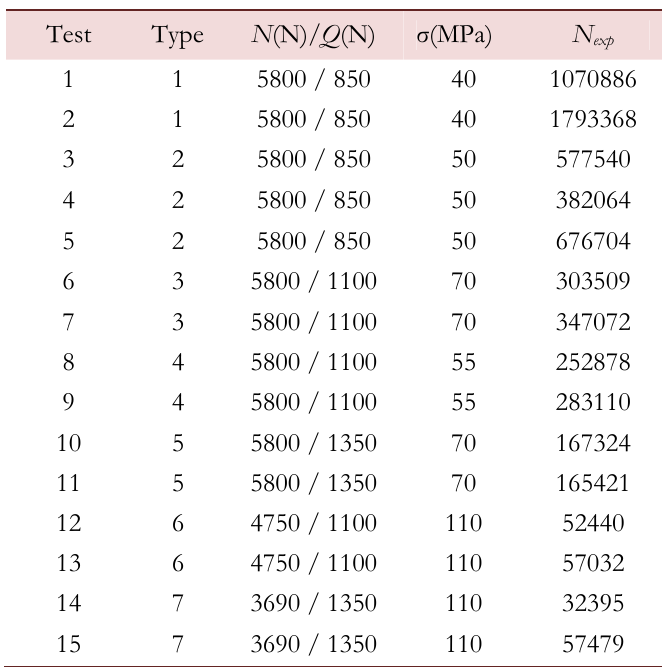
Table 1: Loads ( N and Q ), axial stress ( σ ) and experimental fatigue cycles ( N